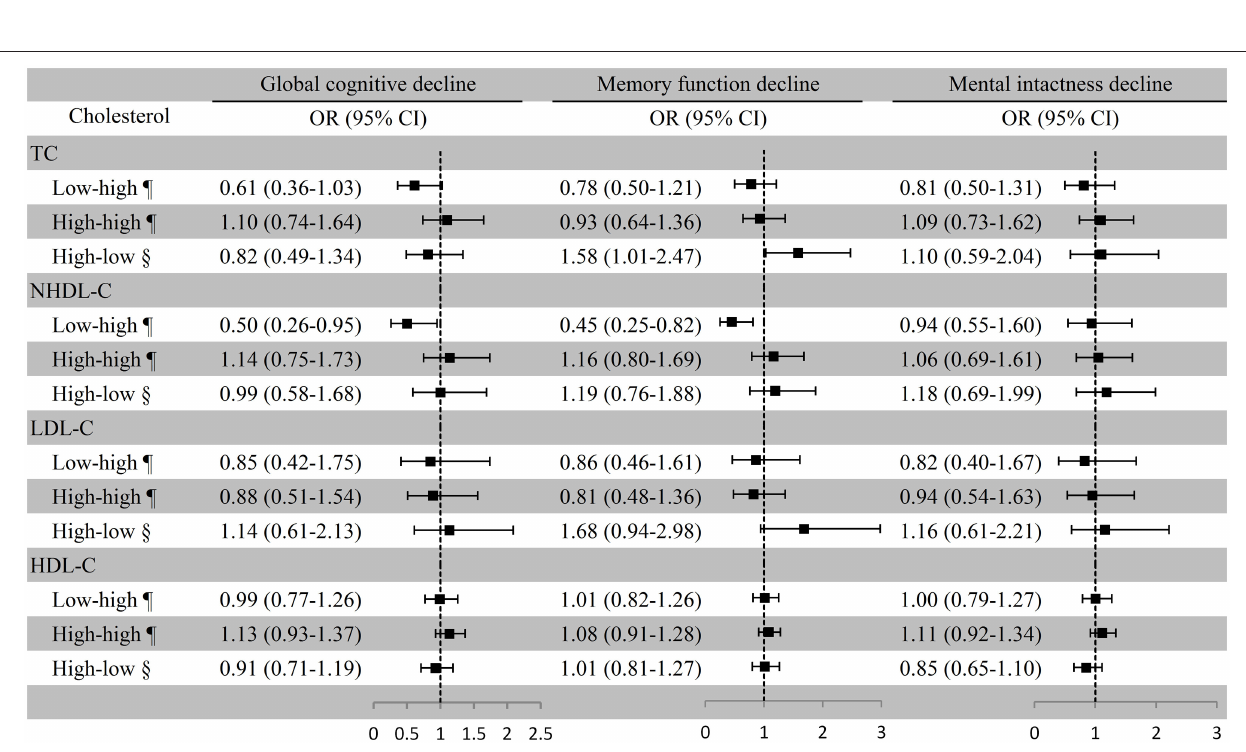
FIGURE 3 | Association between cholesterol variation and cognitive decline among all the participants. ¶ Take the low–low group as a reference; § Take the high–high group as a reference. Baseline age, sex, education, marital status, smoking, drinking, BMI, exercise, physical diseases, medication use (antihypertensive or antidiabetic medications), and the number of comorbidities were adjusted. TC, total cholesterol; NHDL-C, non-high-density lipoprotein cholesterol; LDL-C, low-density lipoprotein cholesterol; HDL-C, high-density lipoprotein cholesterol; OR, odds ratio; CI, confidence interval.